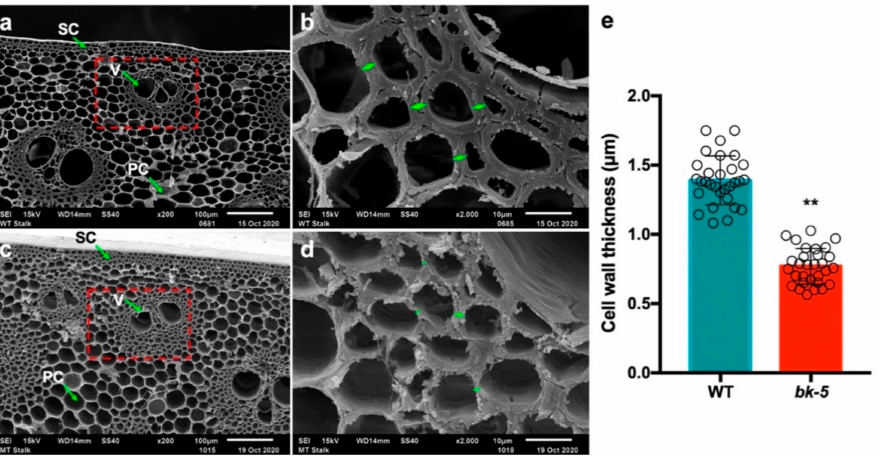
Figure 3. Cross-section of a stalk under a scanning electron microscope. ( a , b ) Cross section of a wild-type stalk. ( c , d ) Cross section of a bk-5 stalk. Two different amplifications of × 200 ( a , c ) and × 2000 ( b , d ) were shown respectively. The third internode above ground of the plant at jointing stage was detected. The green arrow and white text indicate different types of cells, and the red dotted box indicates the indicates the enlarged viewing area. SC, sclerenchyma cells; V, vascular bundles; PC, parenchyma cell. ( e ) Cell wall thickness of bk-5 and wild-type vascular bundle cells that near the sclerenchyma layers. Thirty values of wild-type and bk-5 were determined, respectively. The od circles represent the measured value of each group. The data were measured and calculated by Image J. The data was presented as values are given as means ± SD and statistically calculated by Student’s t -test. and ** ( p < 0.01) indicate significant differences between wild-type and bk-5